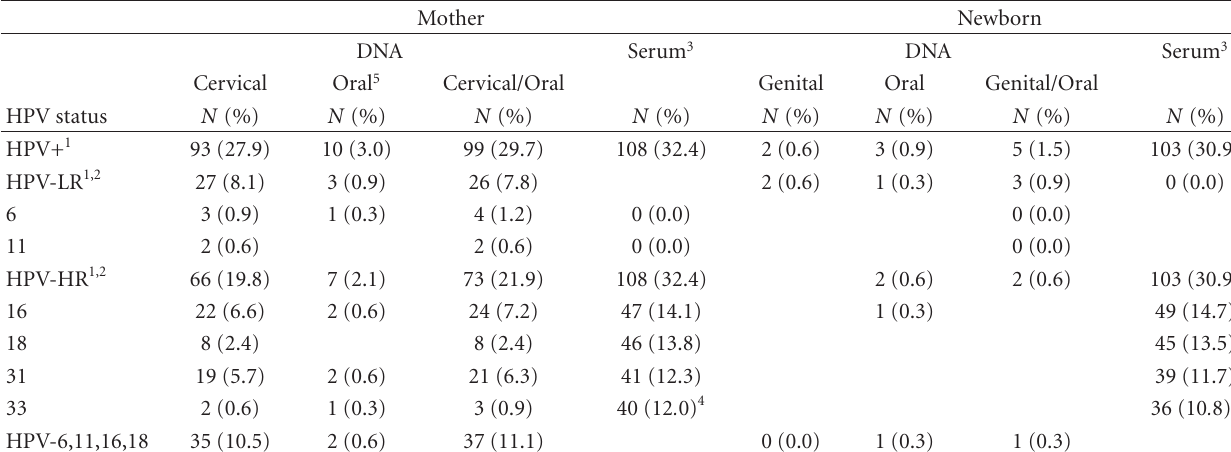
Table 2: HPV types and frequencies in mothers and newborns ( N =